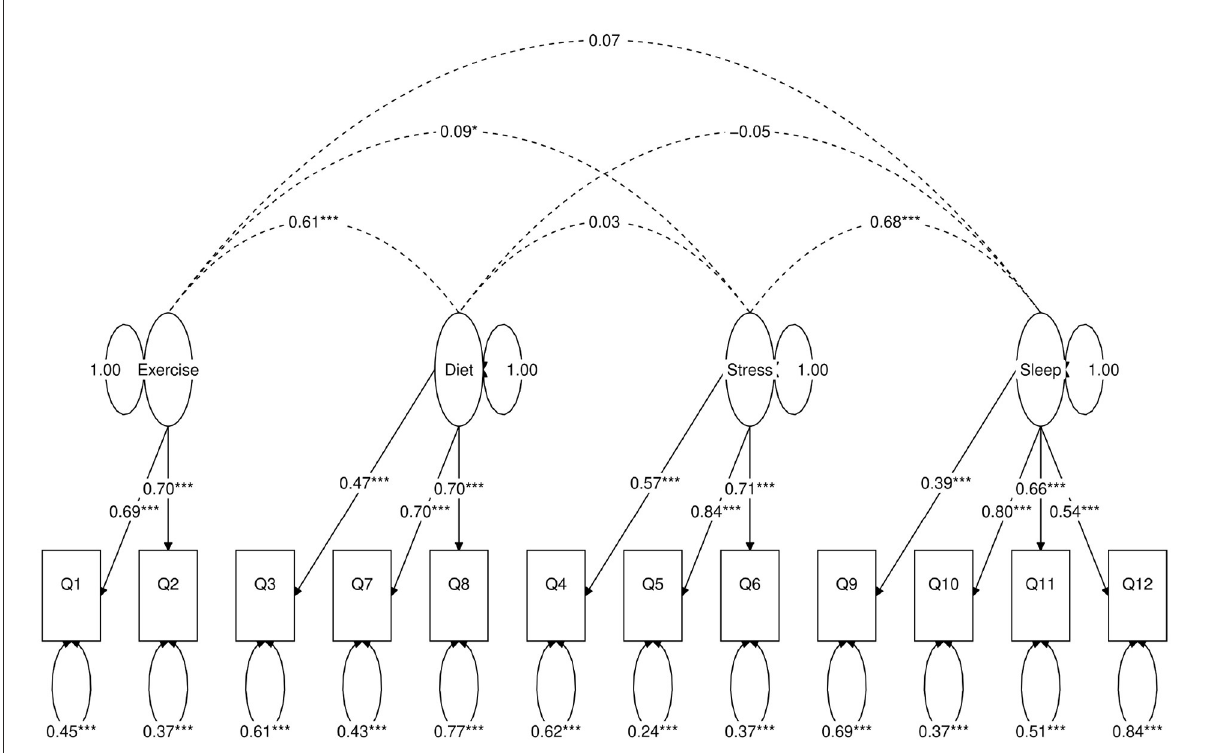
FIGURE4 Path diagram of the first four-factor CFA model (Model A). Star conventions as in Figure